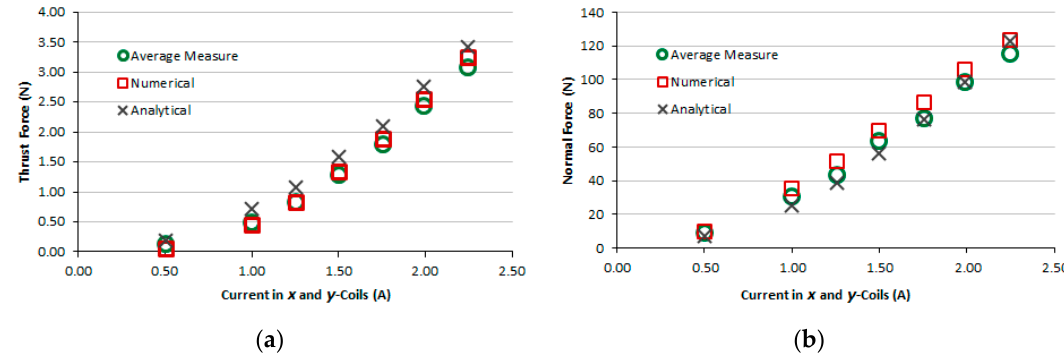
Figure 14. Case 3: ( a ) thrust force and ( b ) normal force produced by the induction planar actuator when both x and y -winding are under current.